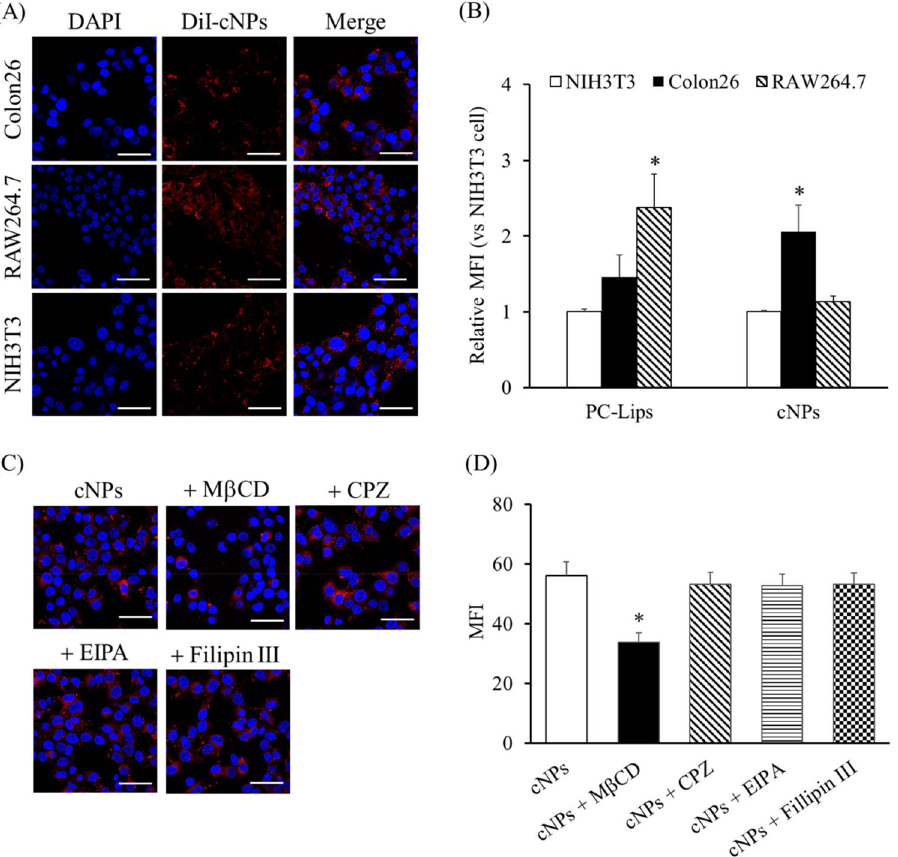
Figure 2. Cellular uptake of cNPs via endocytosis pathway. (A) Confocal microscopic images of DiI-labeled cNPs taken up by colon26, NIH3T3, and RAW264.7 cells. Cells were incubated with DiI-labeled cNPs for 3 h. Scale bars indicate 50 μm. (B) Quantitative flow cytometric analysis of cellular uptake of DiI-labeled cNPs or PC-Lips. The cells were incubated with DiI-labeled cNPs or PC-Lips for 3 h at 37 °C and fixed using 4% paraformaldehyde phosphate buffer solution (PFA). MFI of cNPs or PC-Lips in the cells was quantified by flow cytometry. Results are expressed as the mean ± SD of three samples. *p < 0.05 vs. NIH3T3 cell group. (C) Colon26 cells were incubated with endocytosis inhibitors (0.5 μg/mL Filipin III, 30 μM CPZ, 40 μM EIPA, and 10 mM MβCD) for 40 min and then incubated with DiI-labeled cNPs for 3 h. Cells were fixed and imaged by confocal laser scanning microscopy. Scale bars indicate 50 μm. (D) Quantitative flow cytometric analysis of DiI-labeled cNPs taken up by colon26 cells. Endocytosis inhibitors (0.5 μg/mL Filipin III, 30 μM CPZ, 40 μM EIPA, and 10 mM MβCD) were added to colon26 cells and incubated for 40 min. The cells were incubated with DiI-labeled cNPs for 3 h at 37 °C and fixed using 4% PFA. MFI of cNPs in colon26 cells was quantified by flow cytometry. Results are expressed as the mean ± SD of three samples. *p < 0.05 vs. cNP